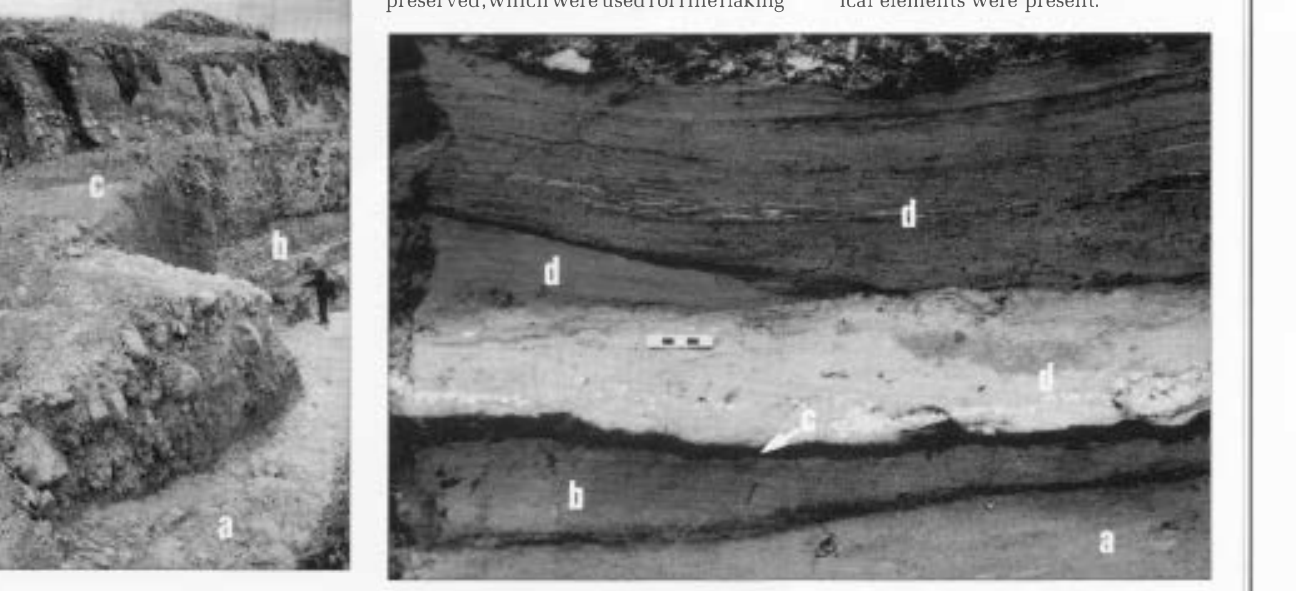
Figure 7 The relict chalk cliff( a), gravels of the raised beach (b) and chalk cliff col­ lapse